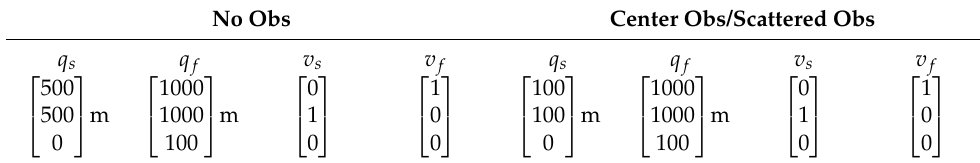
Table 1. Way-points for